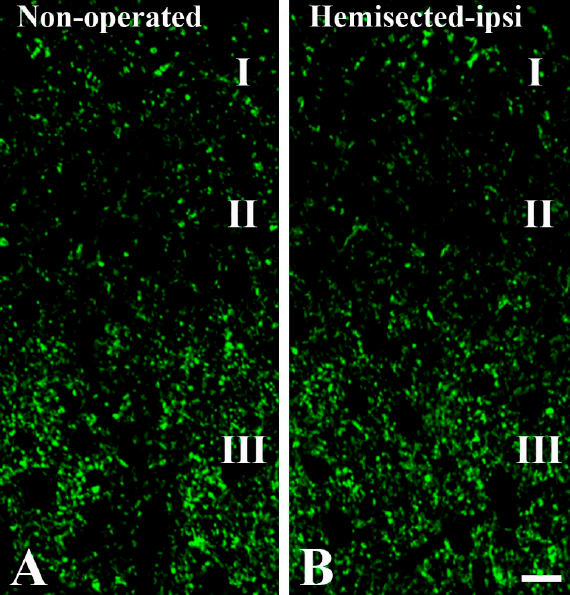
Figure 2. Effect of low thoracic hemisection on GlyT2 immunoreactivity of the lumbar spinal dorsal horn. Photomicrographs showing 1 µm thick optical sections of the ipsilateral super fi cial spinal dorsal horn at the L4 level from a nonoperated animal ( A ) and an animal subjected to hemisection ( B ), following immunostaining for GlyT2. Roman numerals indicate the layers (laminae I, II, and III) of the super fi cial spinal dorsal horn. Bar: 10 µm.